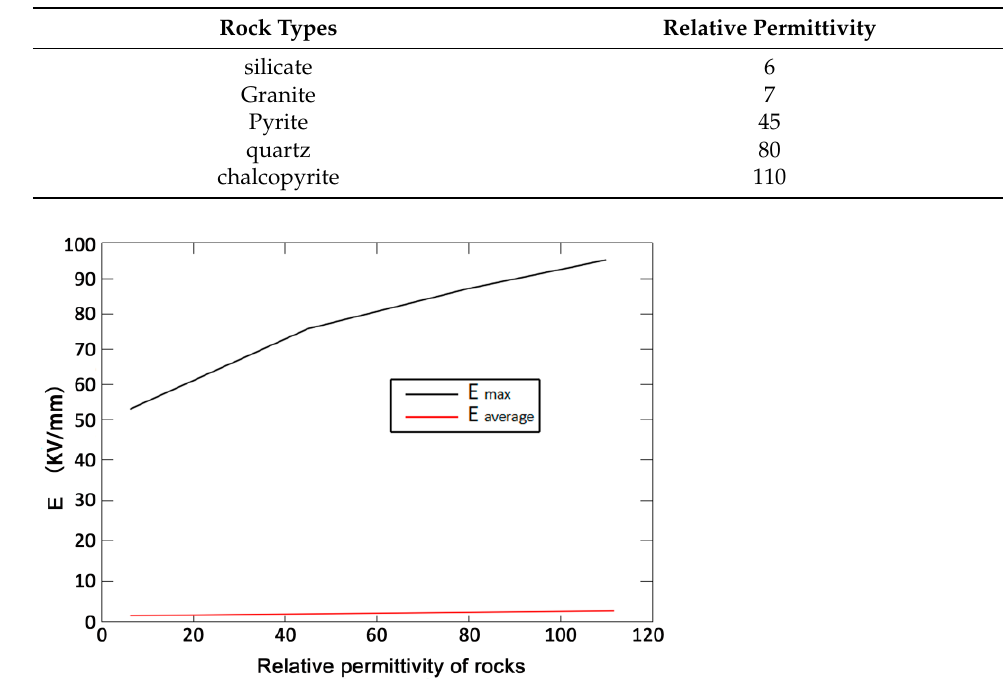
Table 3. Relative permittivity of common rocks.